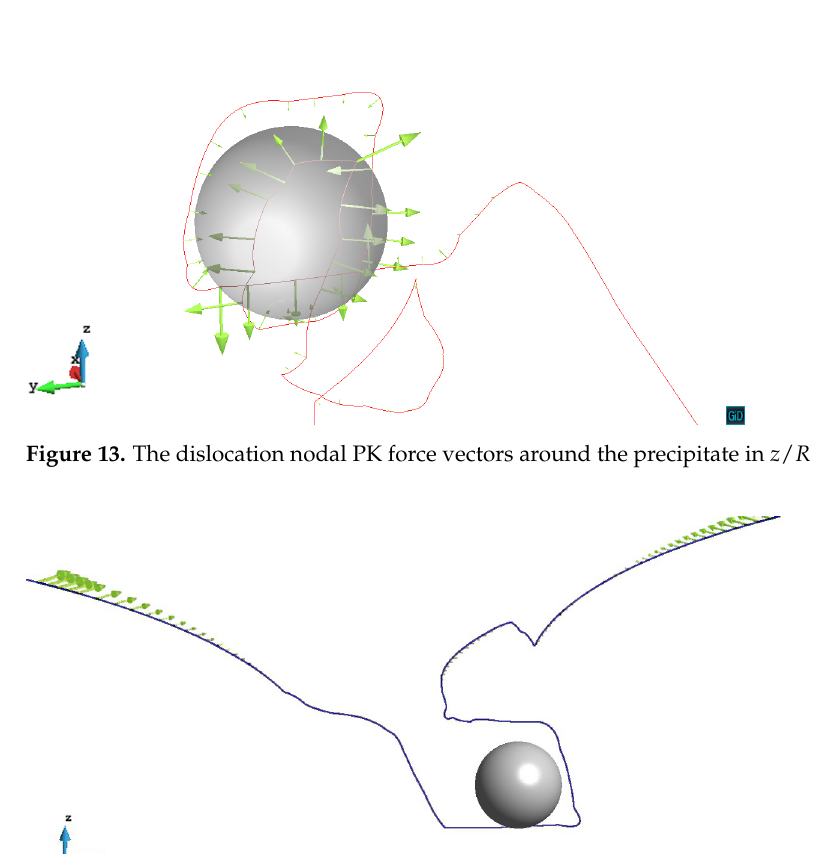
Figure 12. The dislocation topology and nodal velocity vectors in z / R = − 0.6 case. The plastic strain ε = 4.68 × 10 − 4 .